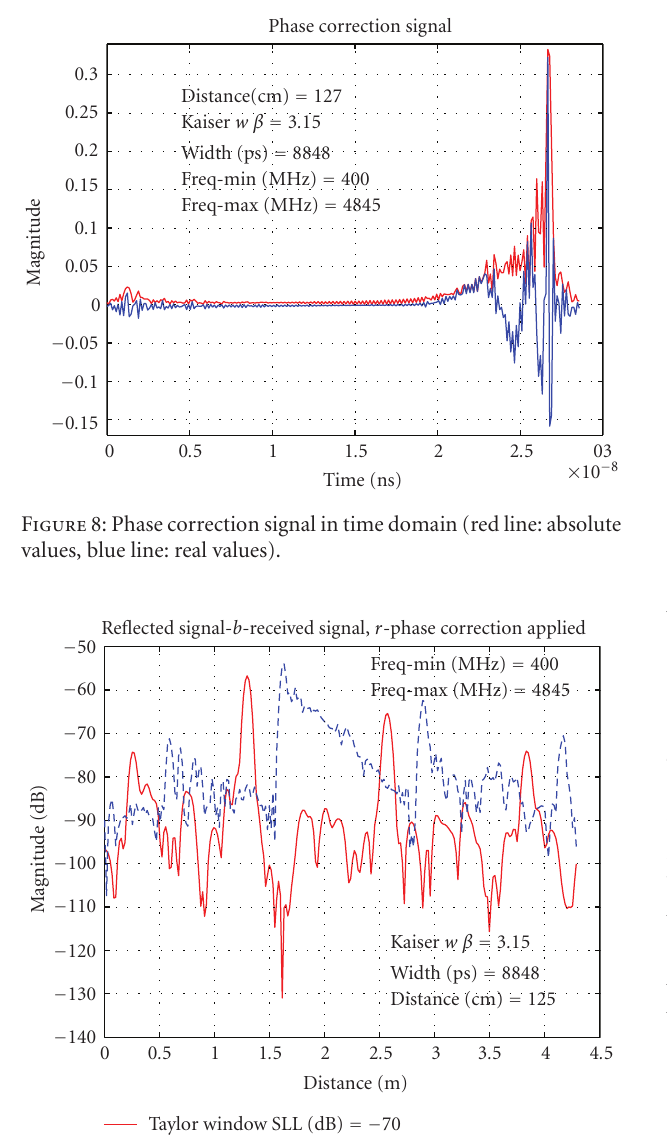
Figure 9: A range profile before calibration (blue line) and after calibration (red line) for a distance of 125 cm; data measured with VNA.